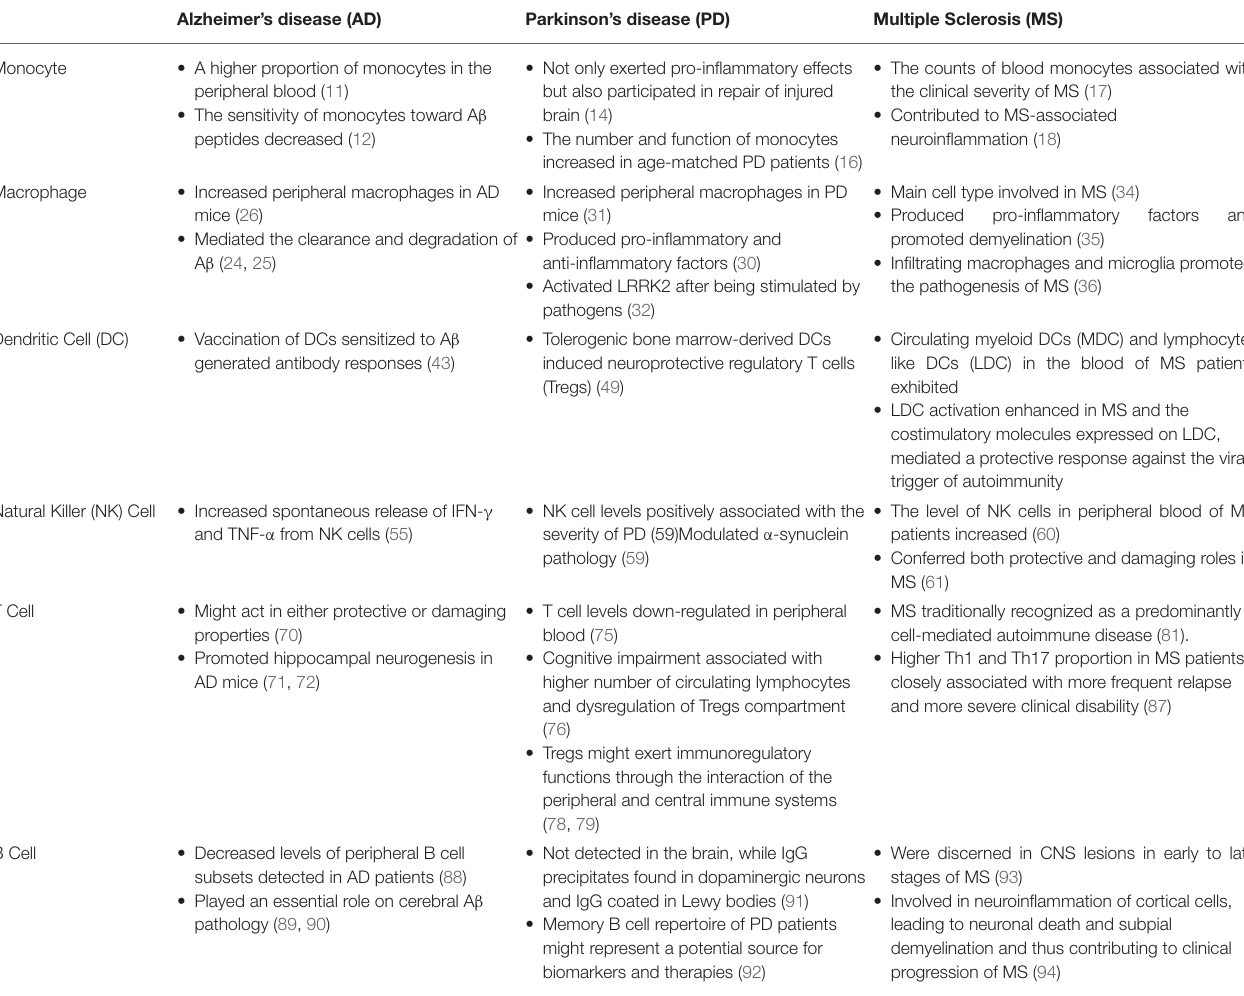
TABLE 1 | Effects of peripheral immune cells on the pathogenesis of neurodegenerative